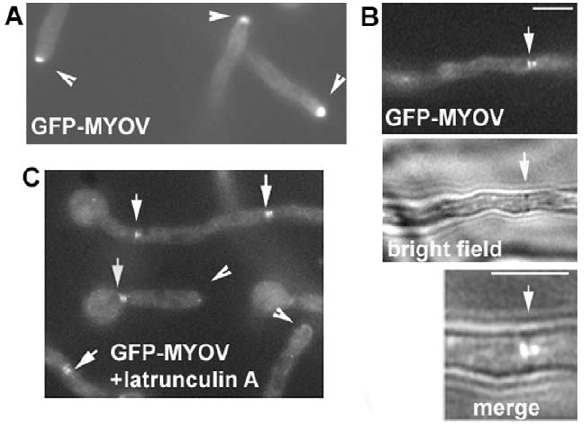
Figure 2. The localization of GFP-MYOV. (A) GFP-MYOV localizes to the hyphal tip. (B) GFP-MYOV localizes on two sides of the septum. (C) The effect of latrunculin A on GFP-MYOV localization. Cells were treated with 12 m M latrunculin A for 20 minutes. Arrowheads point to hyphal tips where the GFP-MYOV signals are diminished. Arrows point to GFP-MYOV signals near septa, which persist after treatments with latrunculin A. Bars, 5 m m.